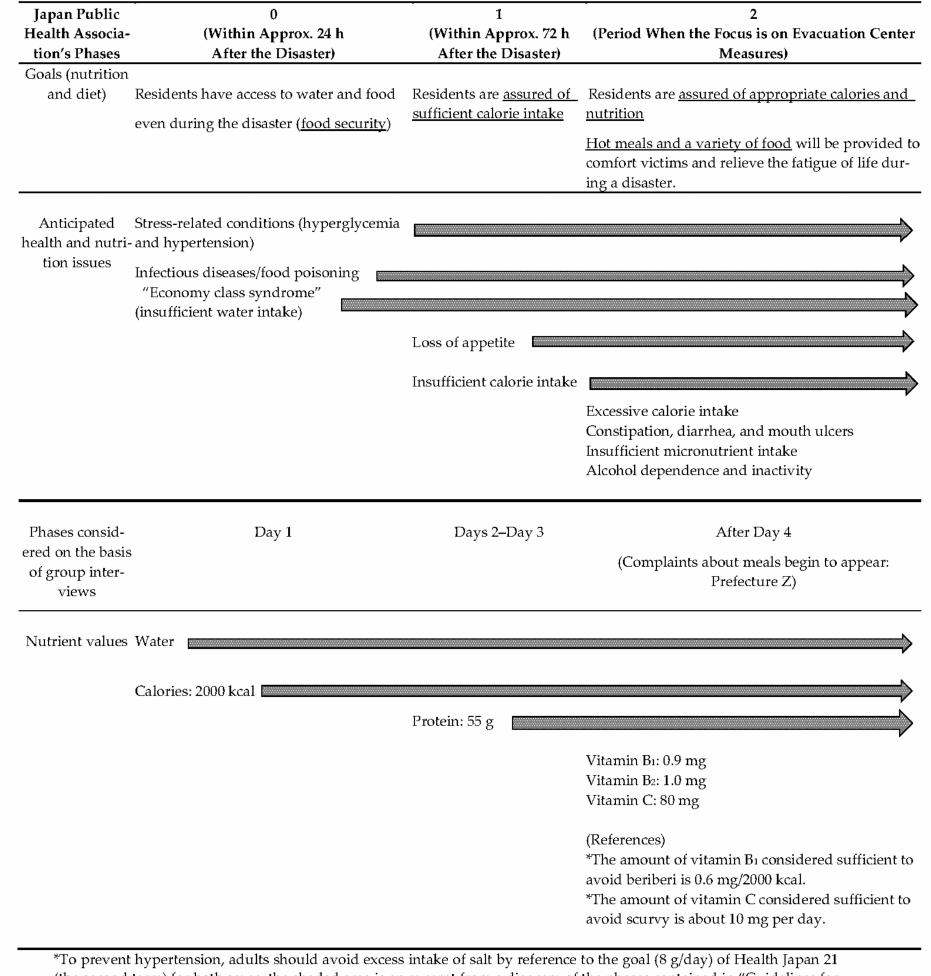
Figure 1. Proposed format for presenting the new nutritional reference values (white